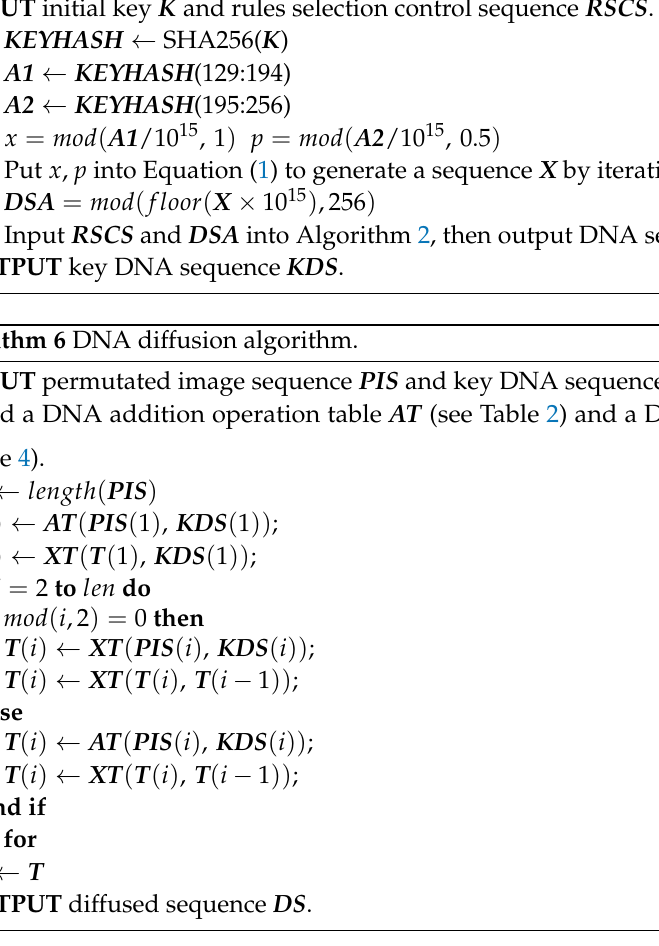
Algorithm 5 Generation algorithm of key DNA sequence (KDS).